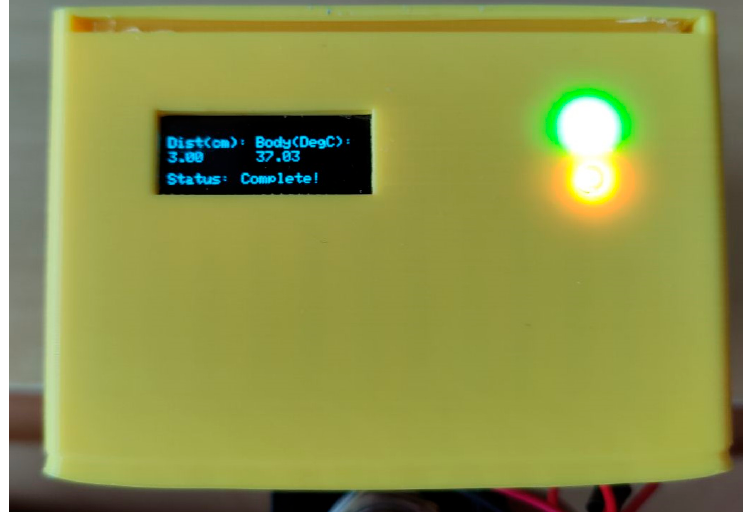
Figure 3. OLED display illustrating the distance to the target surface, measured surface temperature, and the measurement status.